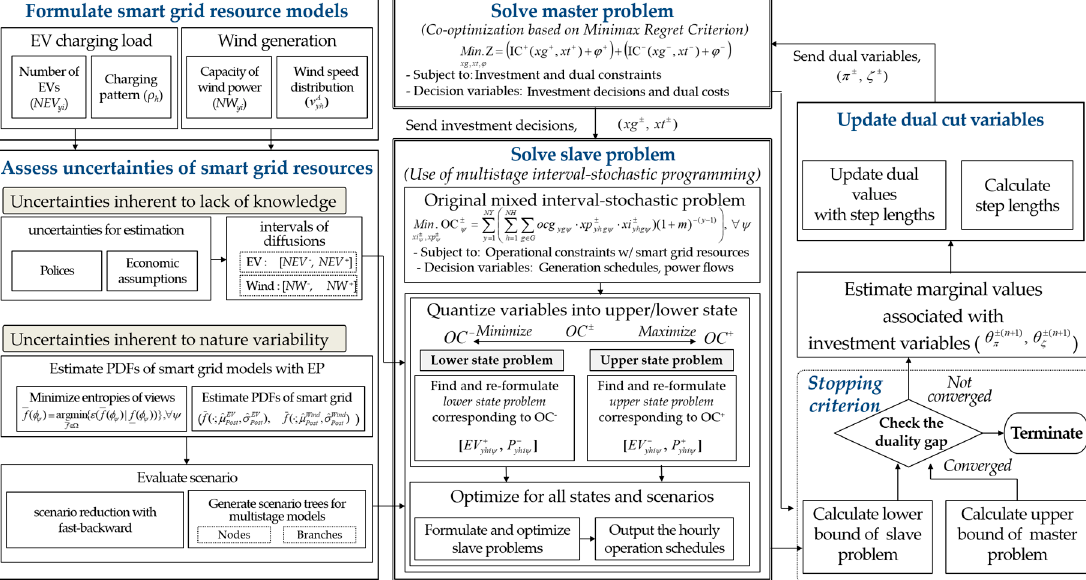
Table 1. Data for Candidate Generation Unit.